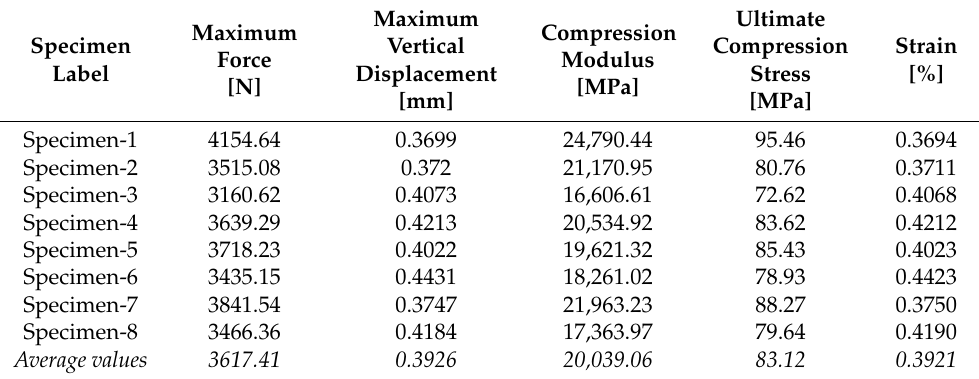
Table 8. Mechanical characteristics of 5052 aluminum alloy honeycomb subjected to compression testing.